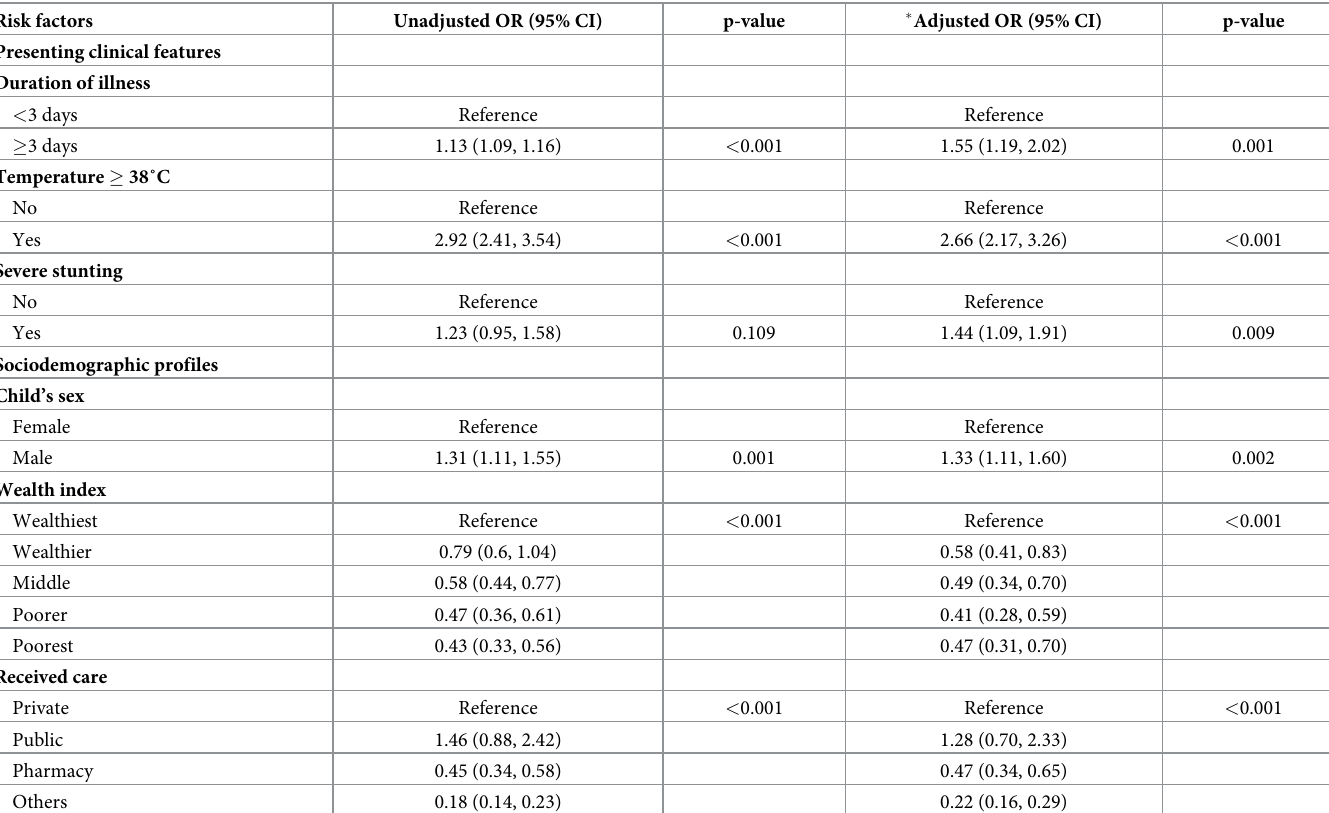
Table 2. Factors associated with severe pneumonia compared to pneumonia among under-five